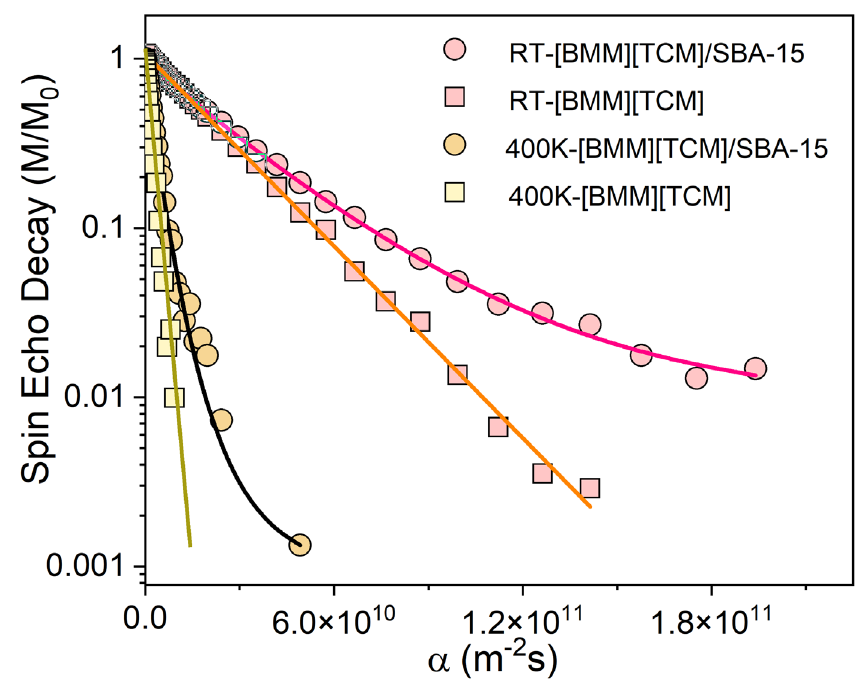
Figure 4. 1 H NMR SED plots of the bulk ionic liquid and confined [BMIM] + [TCM] − ionic liquid in SBA-15 at room temperature and 400 K at the Larmor frequency of 100 MHz and in a constant magnetic field gradient of G = 34.7 Tesla/m. In the case of a homogeneous diffusion process with a single self-diffusion coefficient D, the spin echoes decay according to the law M/M0 = exp( − D α ), where α = (2/3) γ 2 G 2 τ 3